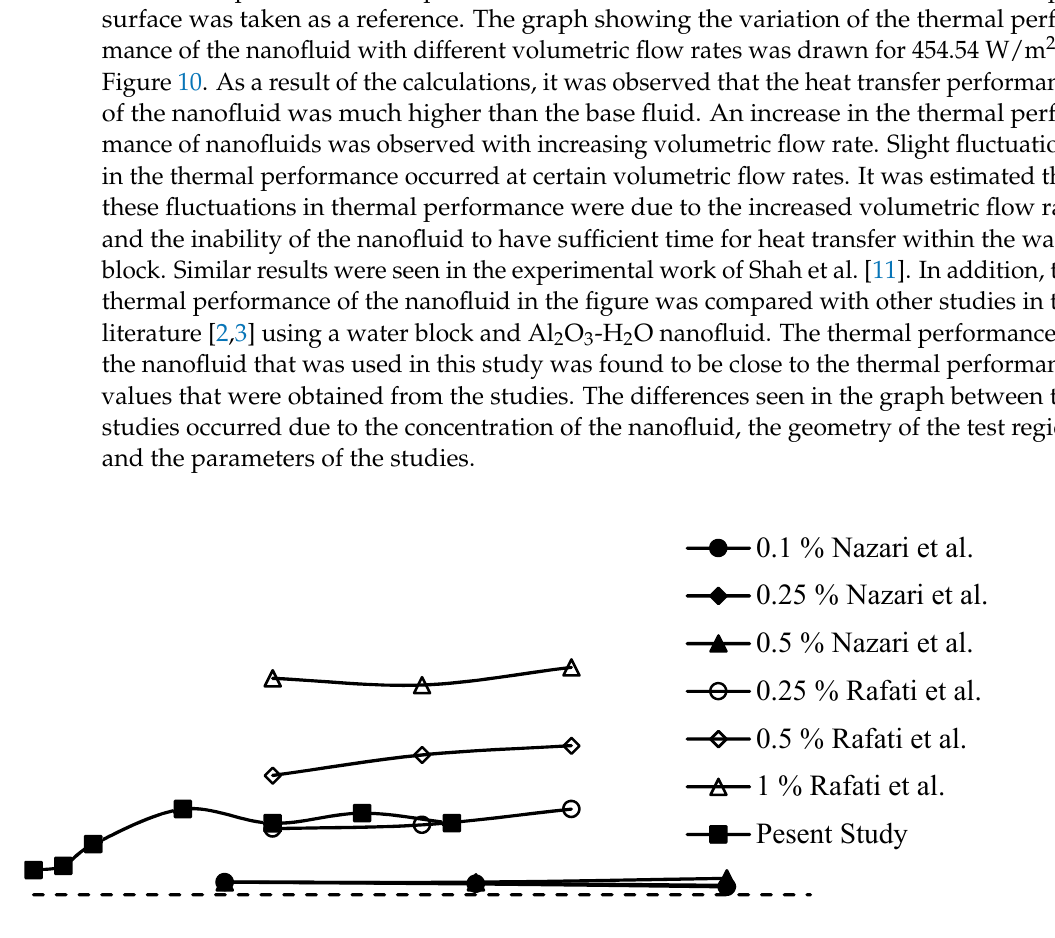
Figure 11. Pumping power versus the volumetric flow rate at different surface type heat sinks. To determine which fin is better than the other in terms of performance in nanofluids, the performance index analysis that was given in equation 13 was performed. In the case of using nanofluid, the variation of the performance index of both the finned heat sinks with volumetric flow rates is given in Figure 12. If the performance index value is less than unity, it is understood that the pressure losses are more dominant than the heat